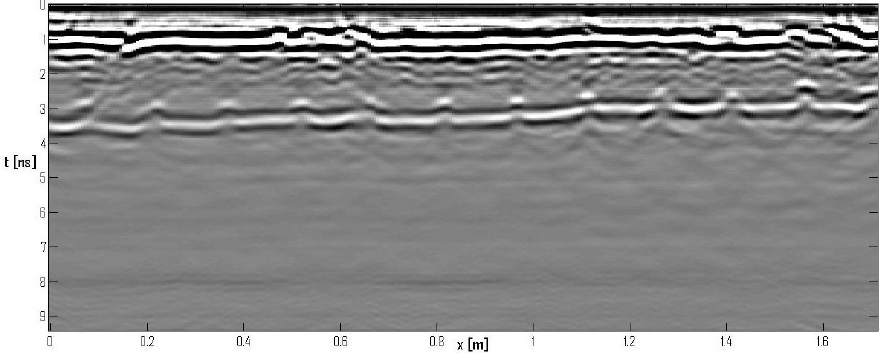
Figure 10. Joined migration with vertical variation of the propagation velocity, merging the results of Figure 8.